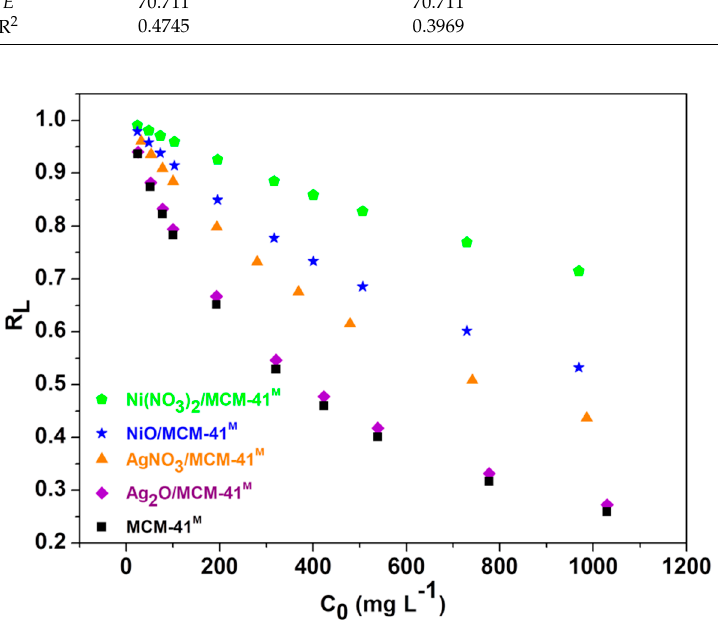
Figure 8. Plots of R L versus initial concentrations.